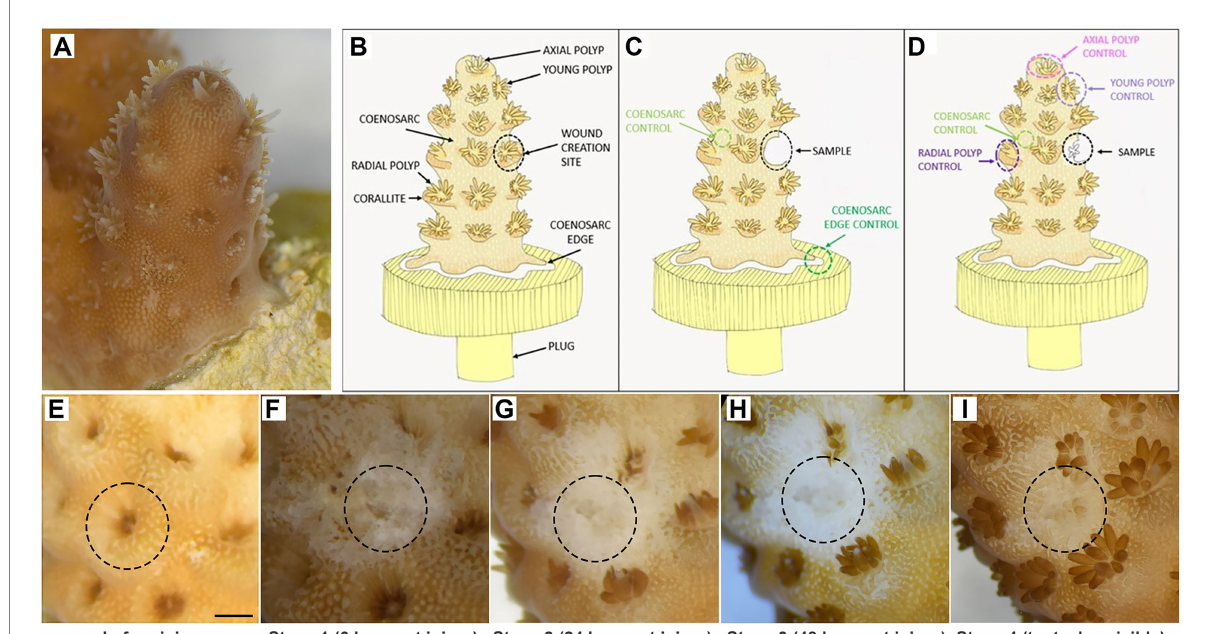
FIGURE 1 Experimental system. (A,B) Small branch of Acropora millepora glued to a plug, with features used for sampling indicated in the diagram. (C,D) Sampling strategy for regeneration stages before (C) and after (D) polyp formation. (E,F) Example images of a single polyp tracked before (E) and after (F) injury and until tentacles of the regenerated polyp became visible (G–I) . Scale bar represents 1